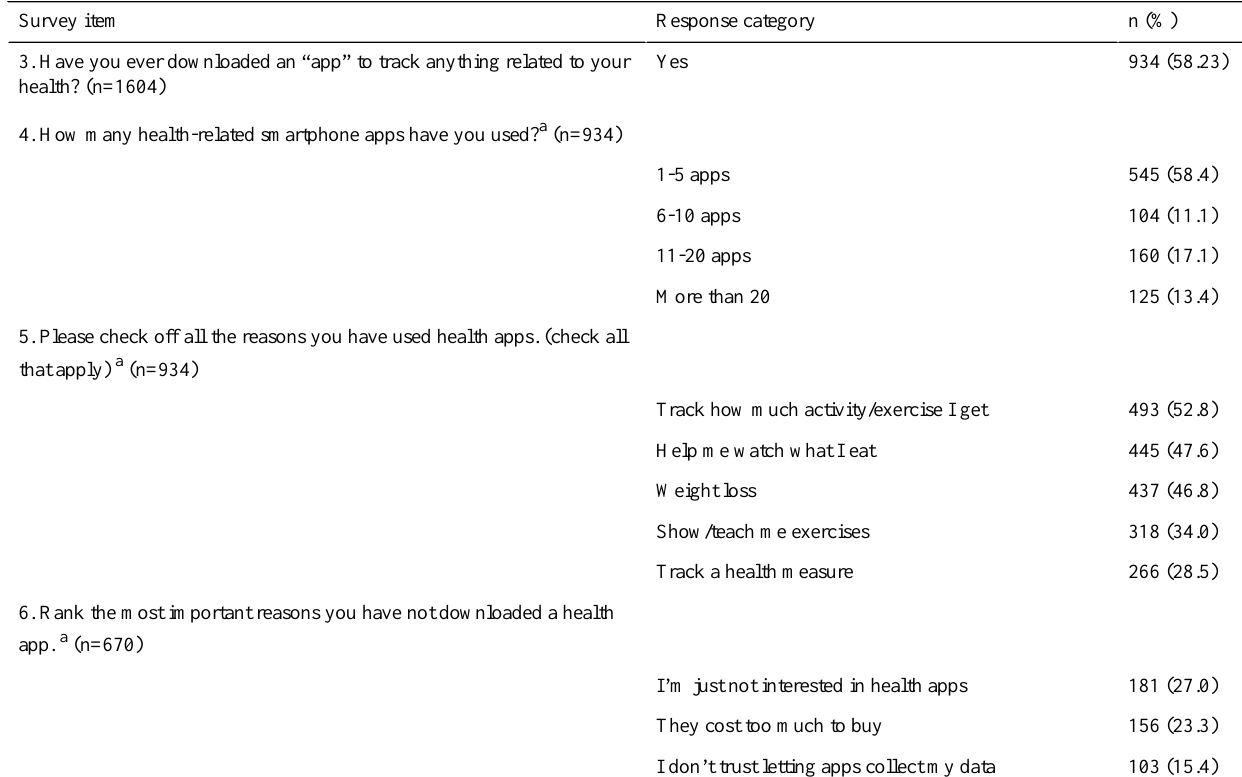
Table 2. Characteristics of health app use (abridged a